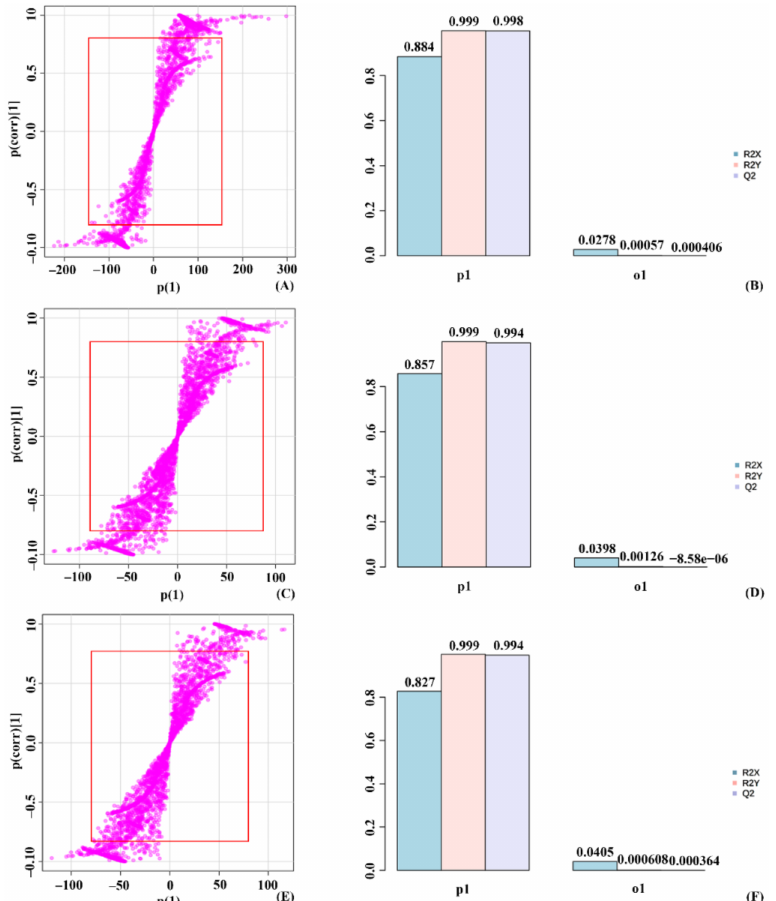
Figure 9. OPLS-DA plot grouping 100 mM stressed plants based on significantly expressed metabo- lites. ( A ) S-plot for control vs. treated_7, ( B ) mdsl plot with T-score and orthogonal T-score for control vs. treated_7, ( C ) S-plot for treated_7 vs. treated_8, ( D ) mdsl plot with T-score and orthogonal T-score for treated_7 vs. treated_8, ( E ) S-plot for treated_8 vs. treated_9, ( F ) mdsl plot with T-score and orthogonal T-score for treated_8 vs.